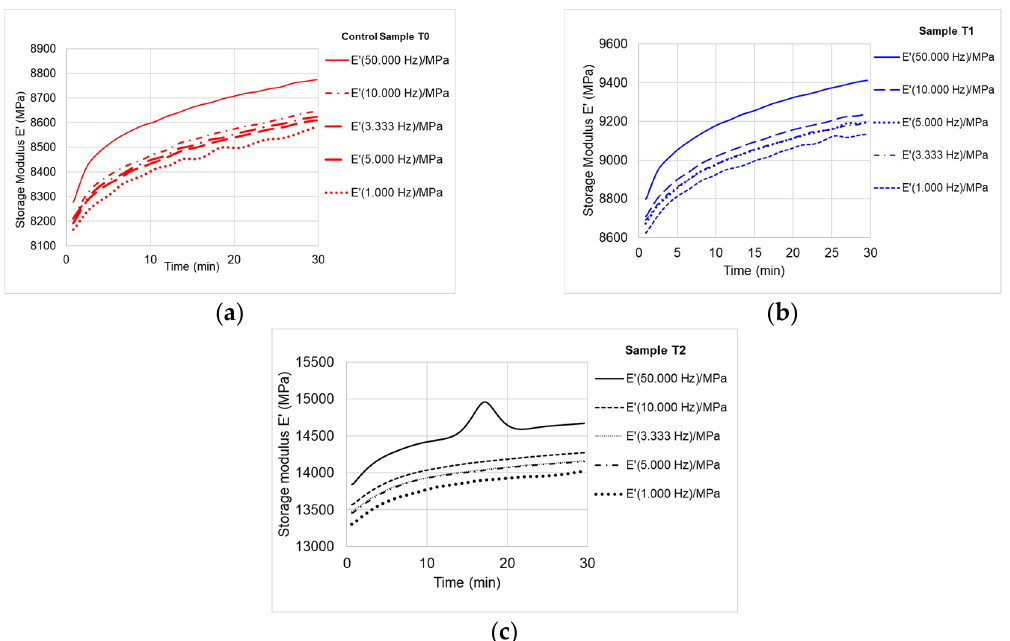
Figure 10. Variation of storage modulus E ’ with loading frequencies: ( a ) control sample; ( b ) sample T1 (first treatment); ( c ) sample T2 (second treatment).